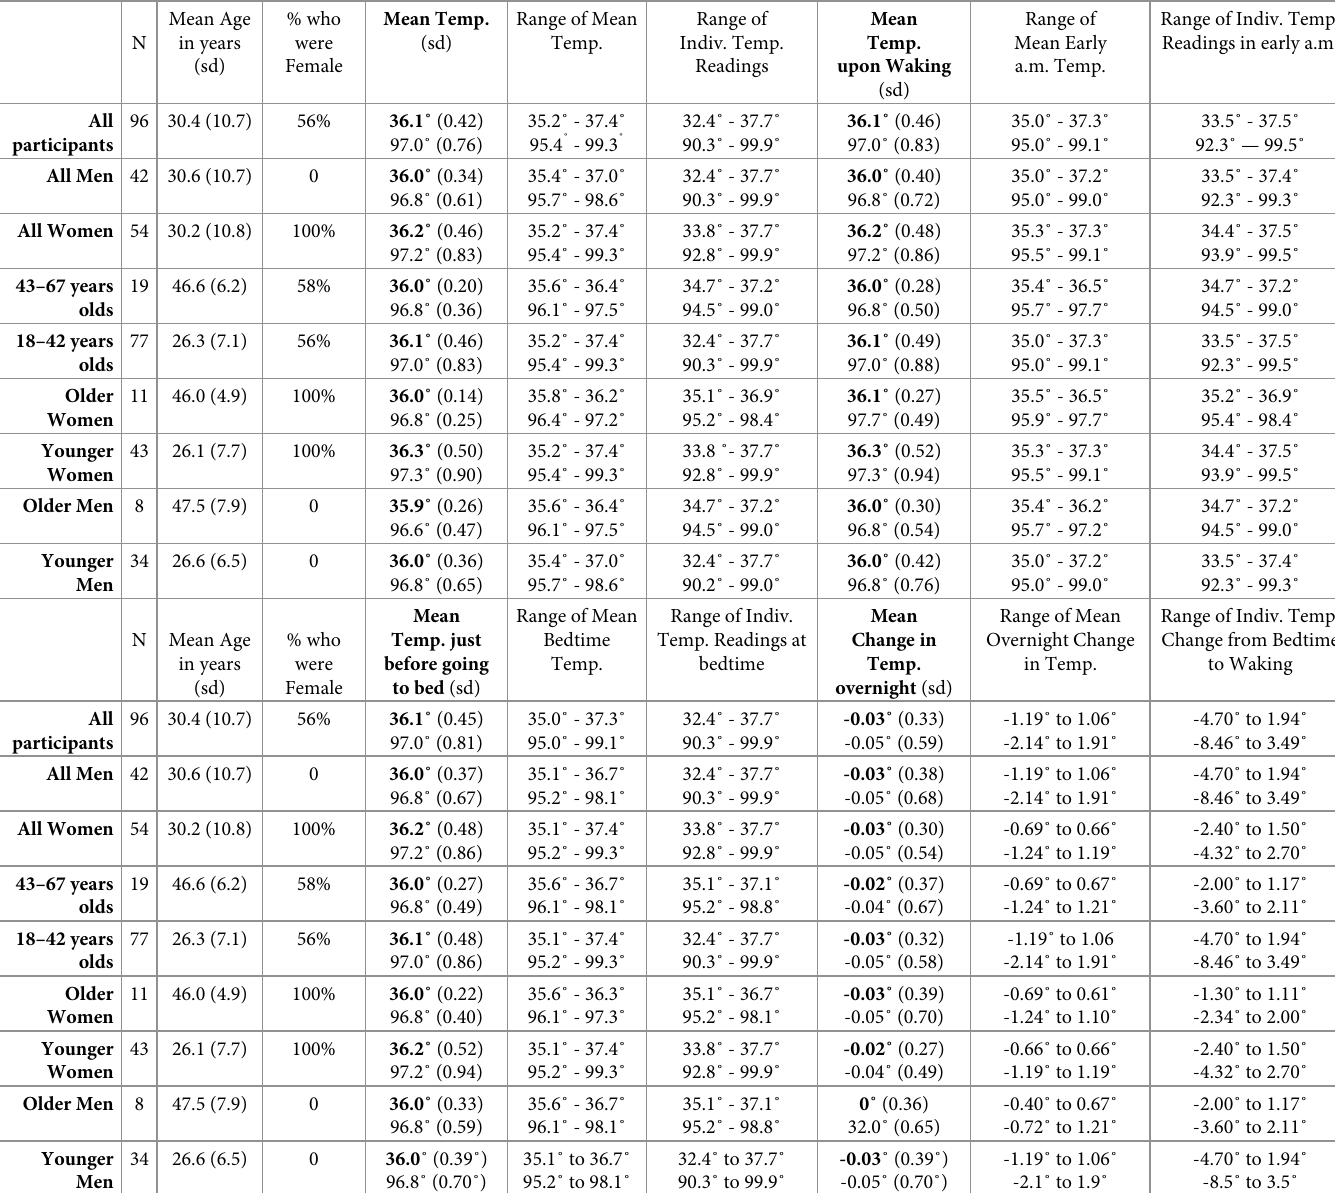
Table 1. Summary of oral temperature results in Celsius and